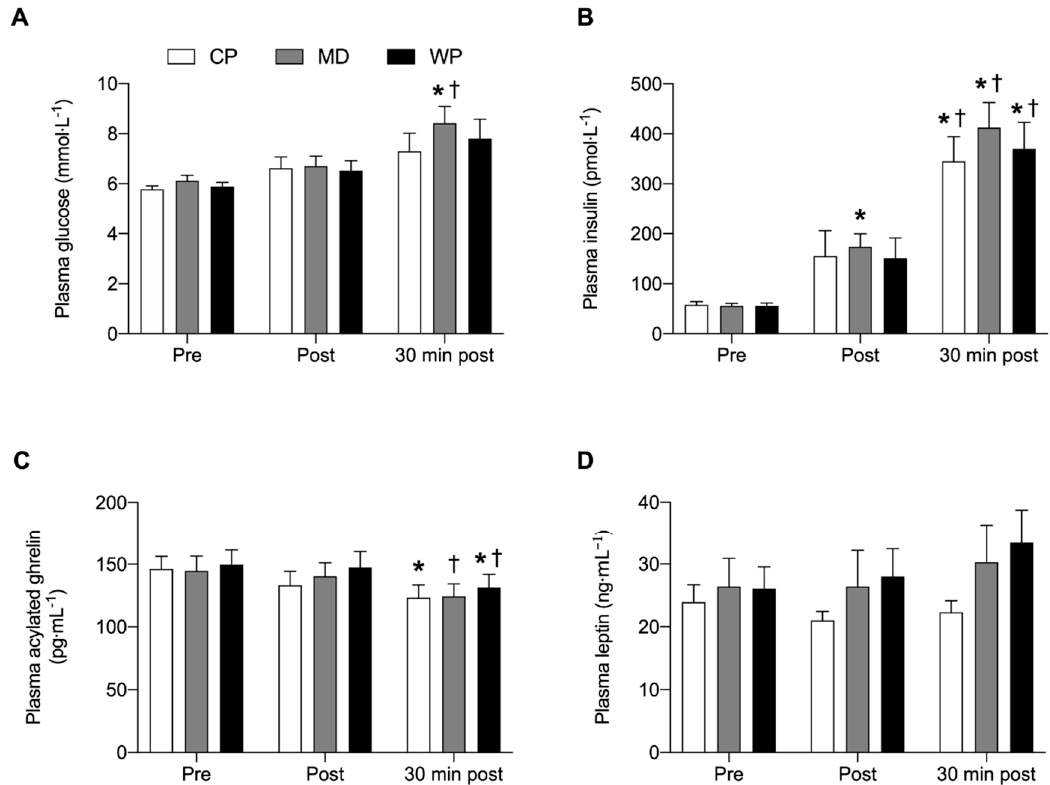
Figure 4. ( A ) Plasma glucose, ( B ) plasma insulin, ( C ) plasma acylated ghrelin and ( D ) plasma leptin concentrations immediately pre, post and 30 min post ad libitum breakfast consumption. Significance was set at p < 0.05. * Indicates significantly different from pre, † indicates significantly different from post. Values are represented as mean with SEM.